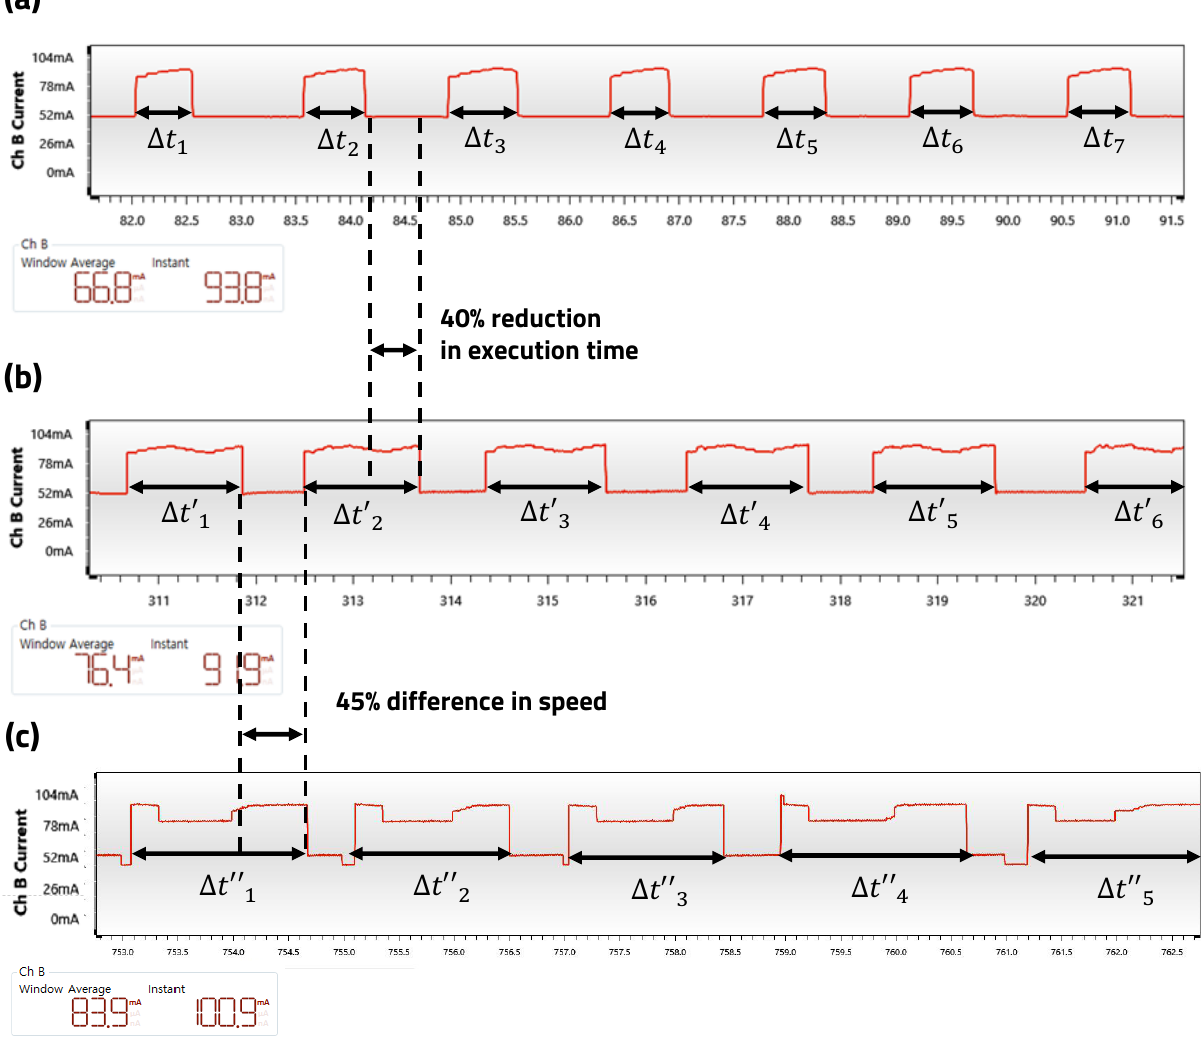
Figure 16. ( a ) Current data of the proposed model. ( b ) Current data of the LSVM model. ( c ) Current data of the CNN